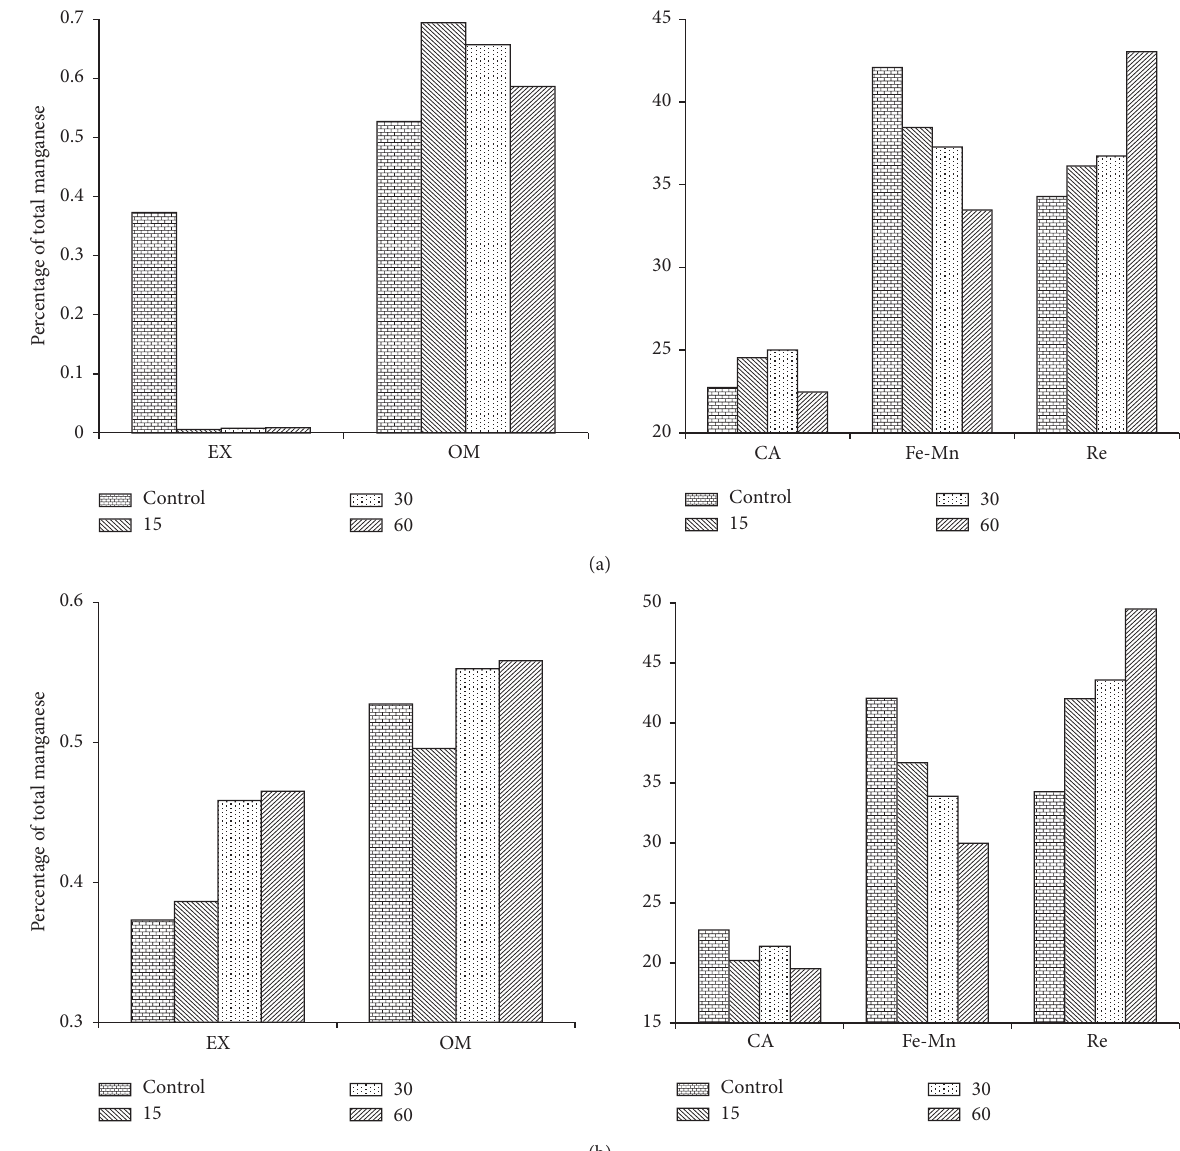
Figure 2: Fractionation of manganese after one-year (a) and two-year (b) application of municipal solid waste compost.